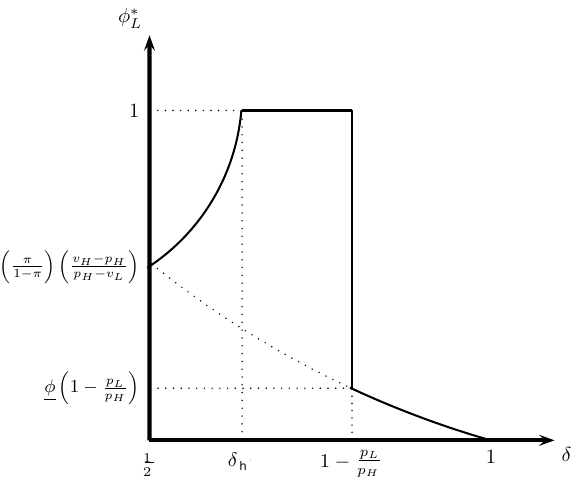
Figure 2. The equilibrium level of fraud as a function the signal precision δ if p H > max ( p L / p H ) δ h < 1 −